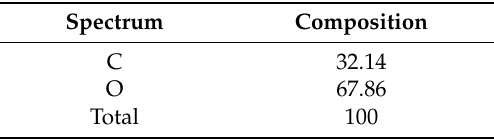
Figure 5. Raman spectra of MWCNTs and PEG/MWCNTs on silicon dioxide recorded from 1000 to 3000 cm −1 with calculated I D /I G ratios. Table 1. The atomic composition of the short MWCNTs. Table 1. The atomic composition of the short MWCNTs.